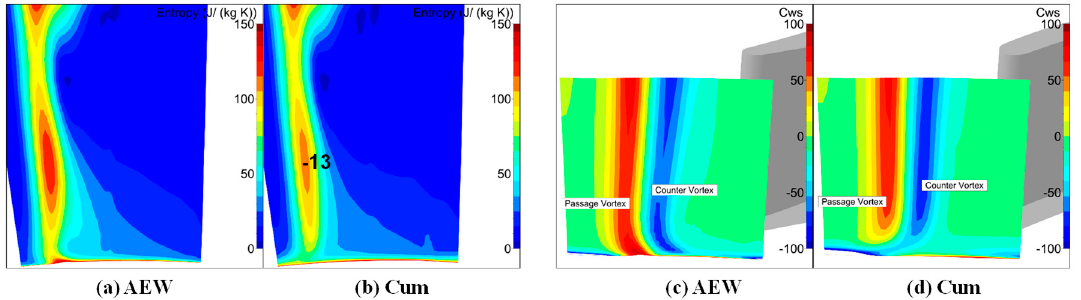
Figure 16. ( a – d ) Comparisons of contours of entropy and helicity at plane 3.